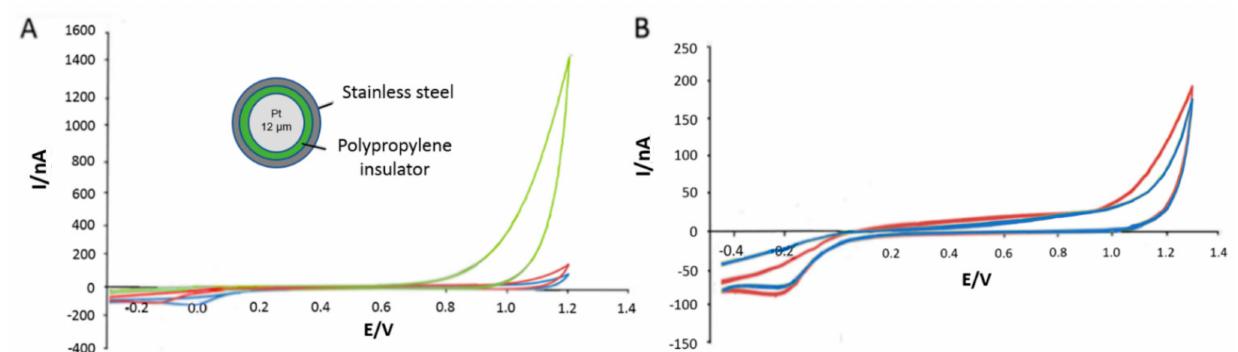
Figure 1. Baseline cyclic voltammograms with bare Pt housed in needle electrode and different pseudoreference electrodes: ( A ) Uncoated stainless steel (green curve); Ag coated stainless steel (by UHV) (red curve), Ag/AgCl included as reference electrode with the uncoated steel (blue curve). Inset shows cross section of needle electrode with Pt insulated wire as working electrode. ( B ) Expanded scale cyclic voltammograms from ( A ) Ag coated stainless steel (red curve); Ag/AgCl included as reference electrode with the uncoated steel (blue curve).